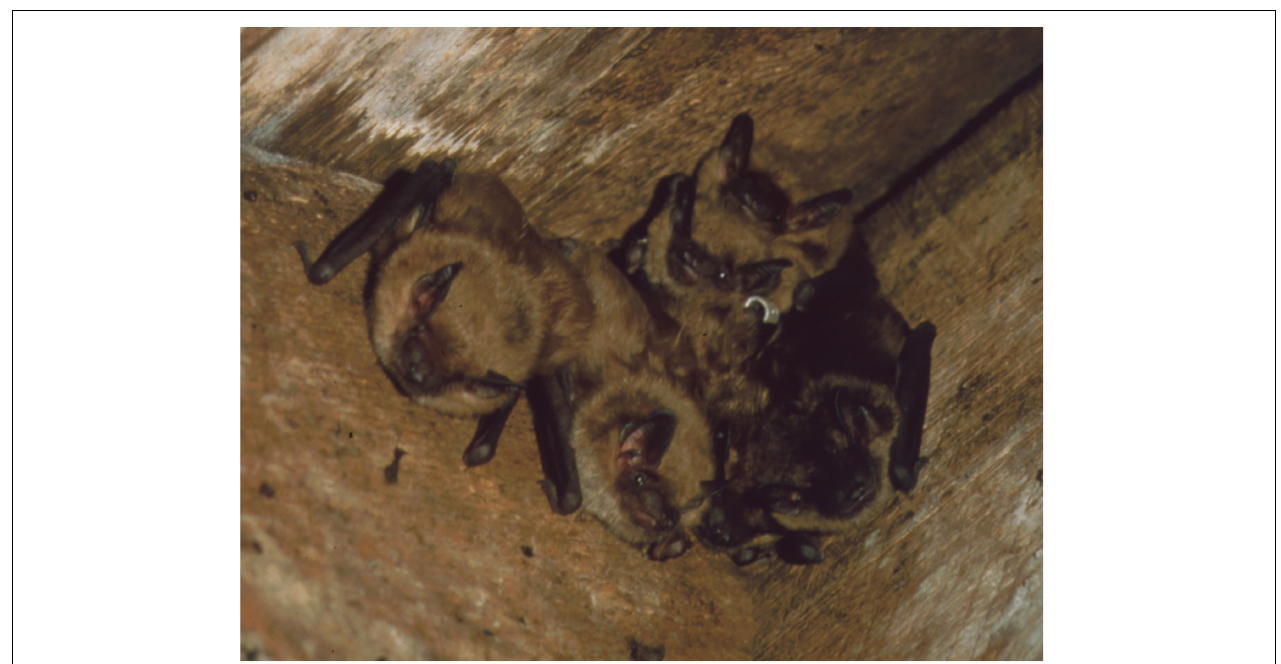
FIGURE 1 | Huddle of at least 7 Eptesicus fuscus bats in a home attic. Note the banded individual at the center. Photo courtesy of Dr. Brock